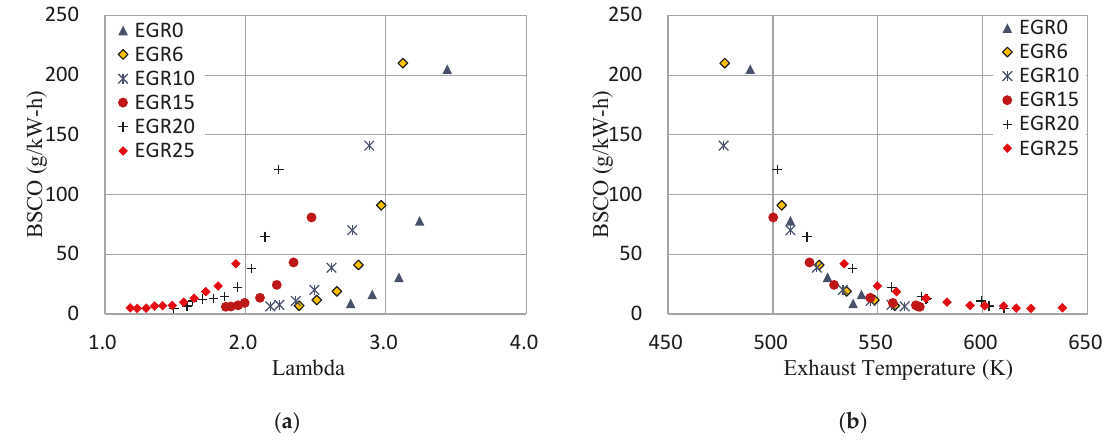
Figure 10. Brake specific CO emission with respect to: ( a ) Lambda; ( b ) Exhaust temperature.